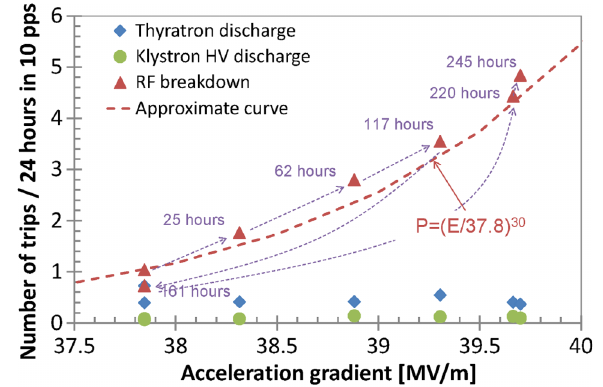
FIG. 16. Typical acceleration gradients versus C -band unit number for 8.5 GeV (red triangle) and 7.9 GeV (blue circle) operation. The variation of the gradient is just the individual difference of the klystron output power.